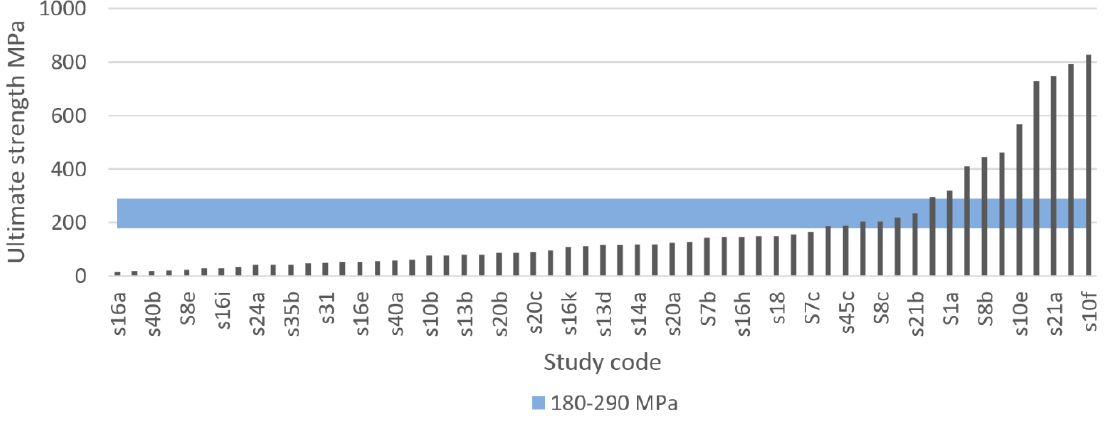
Figure 18. Ultimate compressive strength of porous beam-based metamaterials compared with the Ideal Quality Attribute (IQA) target